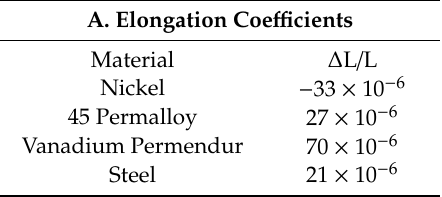
Table 1. Elongation coe ffi cient of the analyzed magnetostrictive